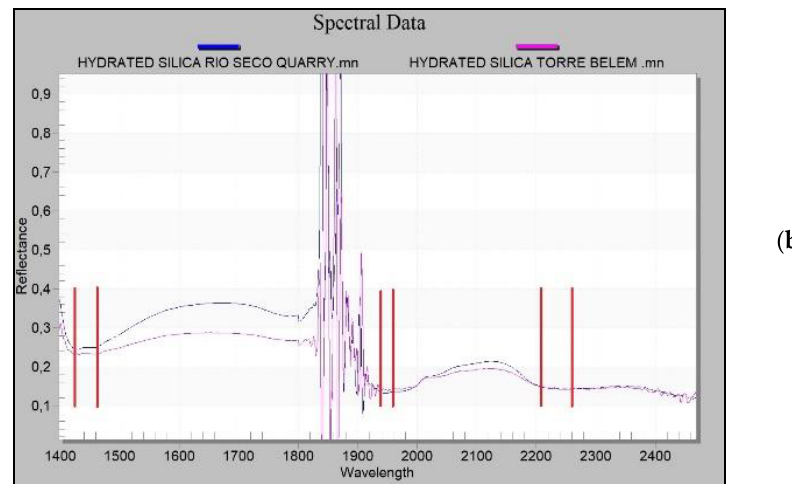
Figure 27. Comparison between the samples from the Tower of Belém and from the area of hydrated silica in the Rio Seco quarry. ( a ) Spectral signatures of the studied silica; ( b ) Common and characteristic absorption peaks of the silica types analyzed.